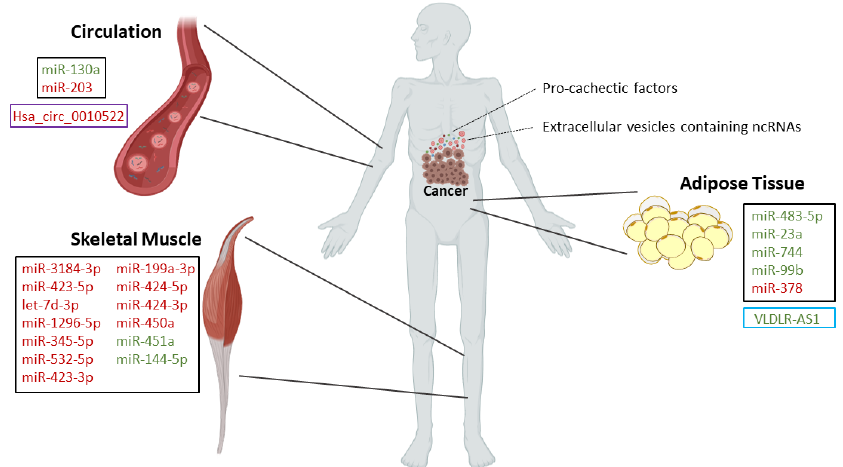
Figure 2. Circulating ncRNAs and dysregulated ncRNAs during muscle and adipose tissue wasting in cancer cachectic patients : Squares in black refer to microRNAs, in blue refer to long non-coding RNAs and in purple refer to circular RNAs. Upregulated non-coding RNAs are in red and downregulated non-coding RNAs are in green. Table 1. MicroRNAs (miRs) involved in muscle wasting.